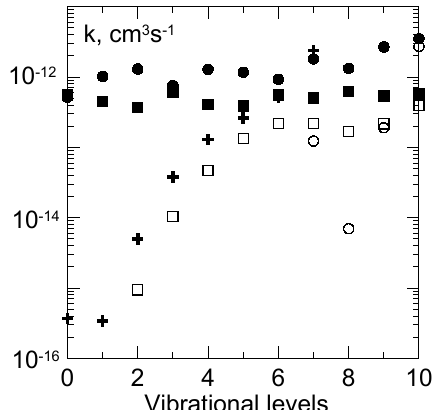
Fig. 6. The calculated rate coefficients for processes (1a) and (4) – open and solid squares, respectively, for processes (1e) and (3) – open and solid circles, respectively; experimental data by Dreyer and Perner (1973) – crosses.